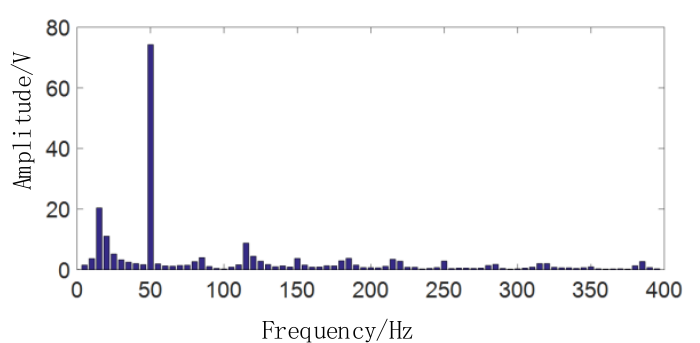
Figure 7. Frequency spectrum of the single-phase waves.